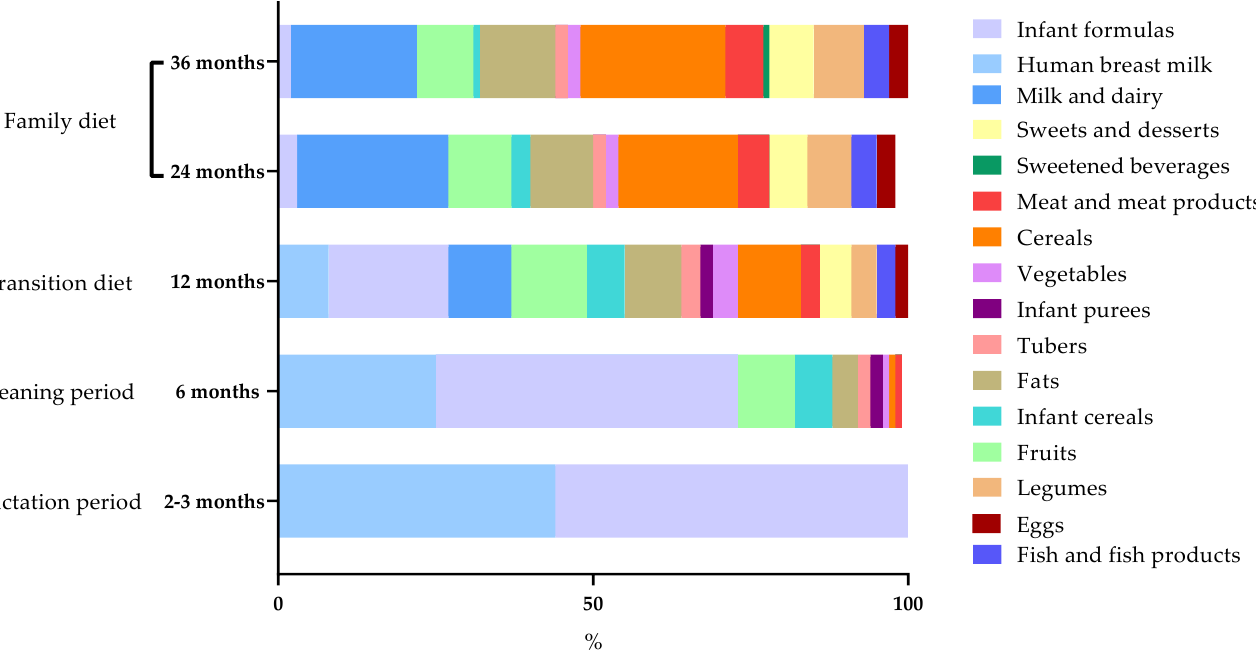
Figure 2. Change in the energy provided by food groups across the follow up.